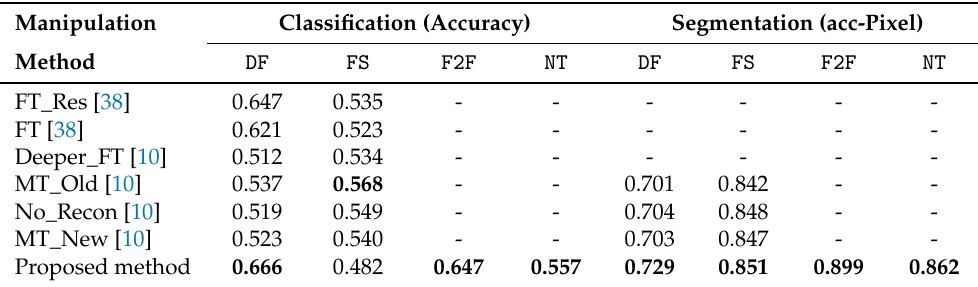
Table 2. Comparison of detecting images altered by the unseen manipulation methods with the proposed method and the method of Nguyen et al. [10] with zero-shot. In this table, bold font is used to emphasize the best values of each indicator. In this table, acc-pixel stands for pixel-wise accuracy. In order to shorten the length of the table, DF in this table stands for DeepFakes , FS stands for FaceSwap , F2F stands for Face2Face , and NT stands for NeuralTextures .